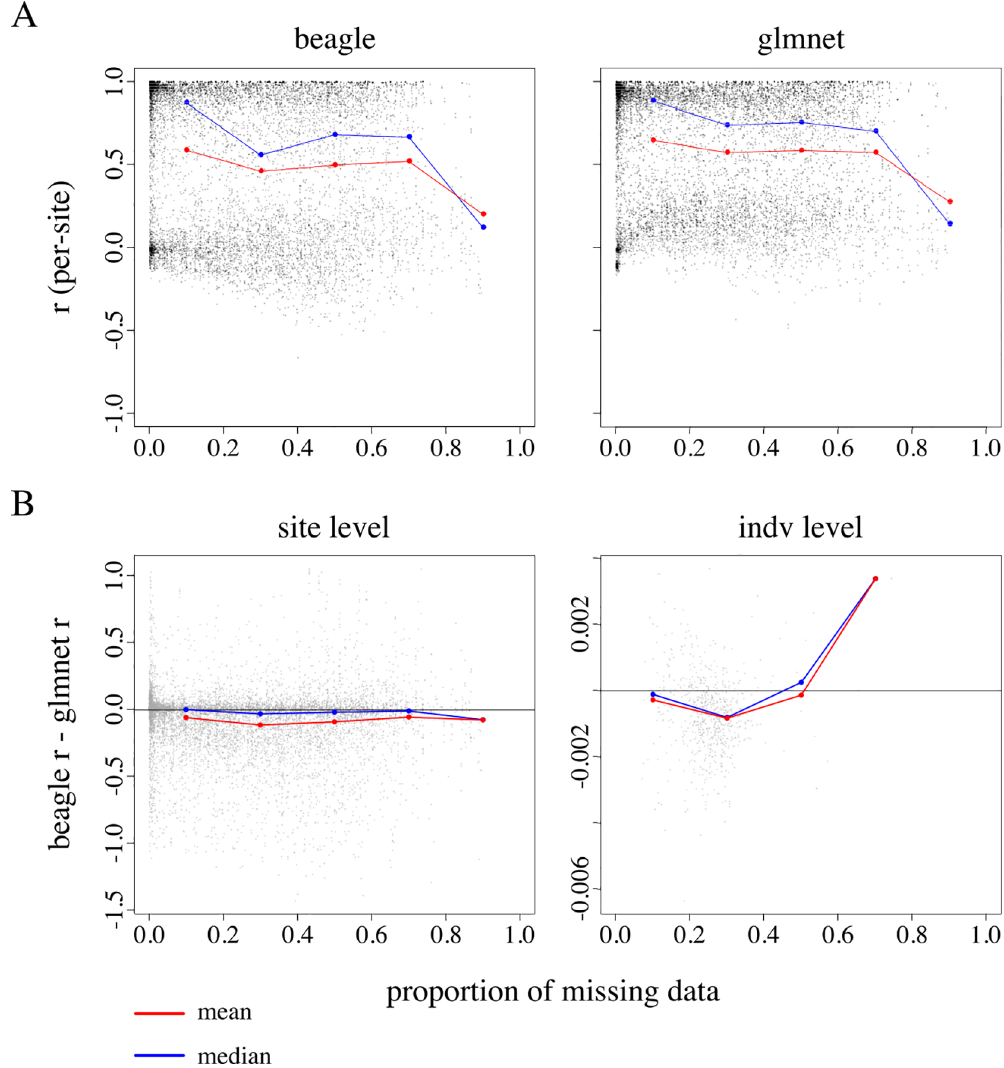
Fig 3. Per-site and per-individual imputation accuracy as a function of missing data and median read depth. (A) Beagle and glmnet imputation accuracy as a function of missing data for sites in set C ( n = 9737). (B) The x - and y -axis display the proportion of missing data and the accuracy difference between Beagle and glmnet at the site and individual level. The range of x is divided into ten-equally sized bins (i.e. 0 . 00 < x (cid:4) 0 . 10 , 0 . 10 < x (cid:4) 0 . 20 , ... , 0 . 90 < x (cid:4) 1 . 00 ), and accuracy differences are divided into bins according to levels of missing data. Bin means and medians, summarizing the data within each bin, are displayed as red and blue points, respectively. Points falling on the black vertical line at y = 0 indicate no observed accuracy difference between Beagle and glmnet imputation. Points falling below y = 0 represent cases where glmnet imputes with higher accuracy relative to